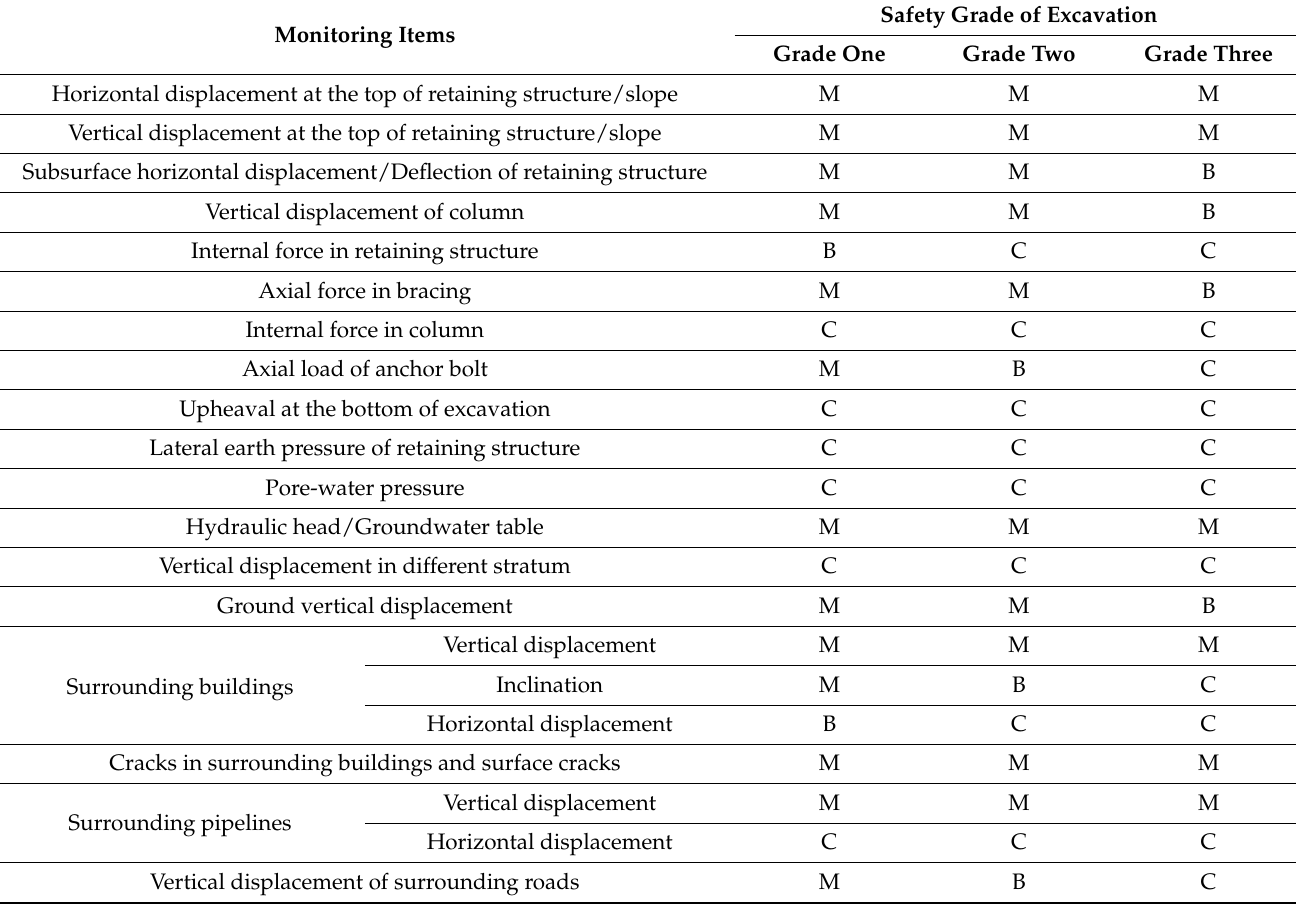
Table 2. Instrument monitoring items of soil mass excavation